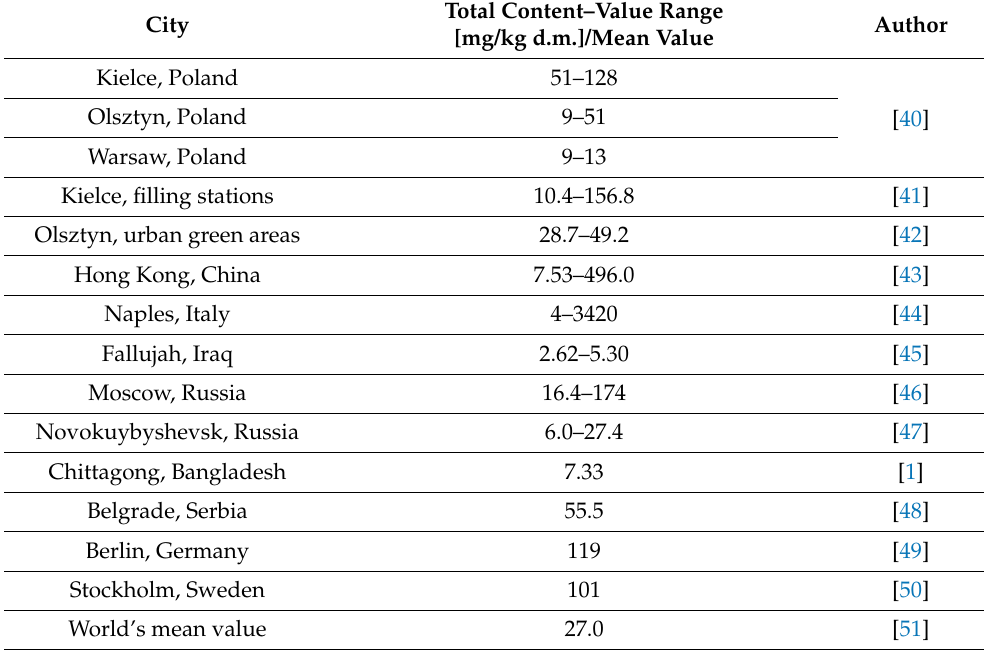
Table 5. Diversification of lead concentrations in the urban soils of the